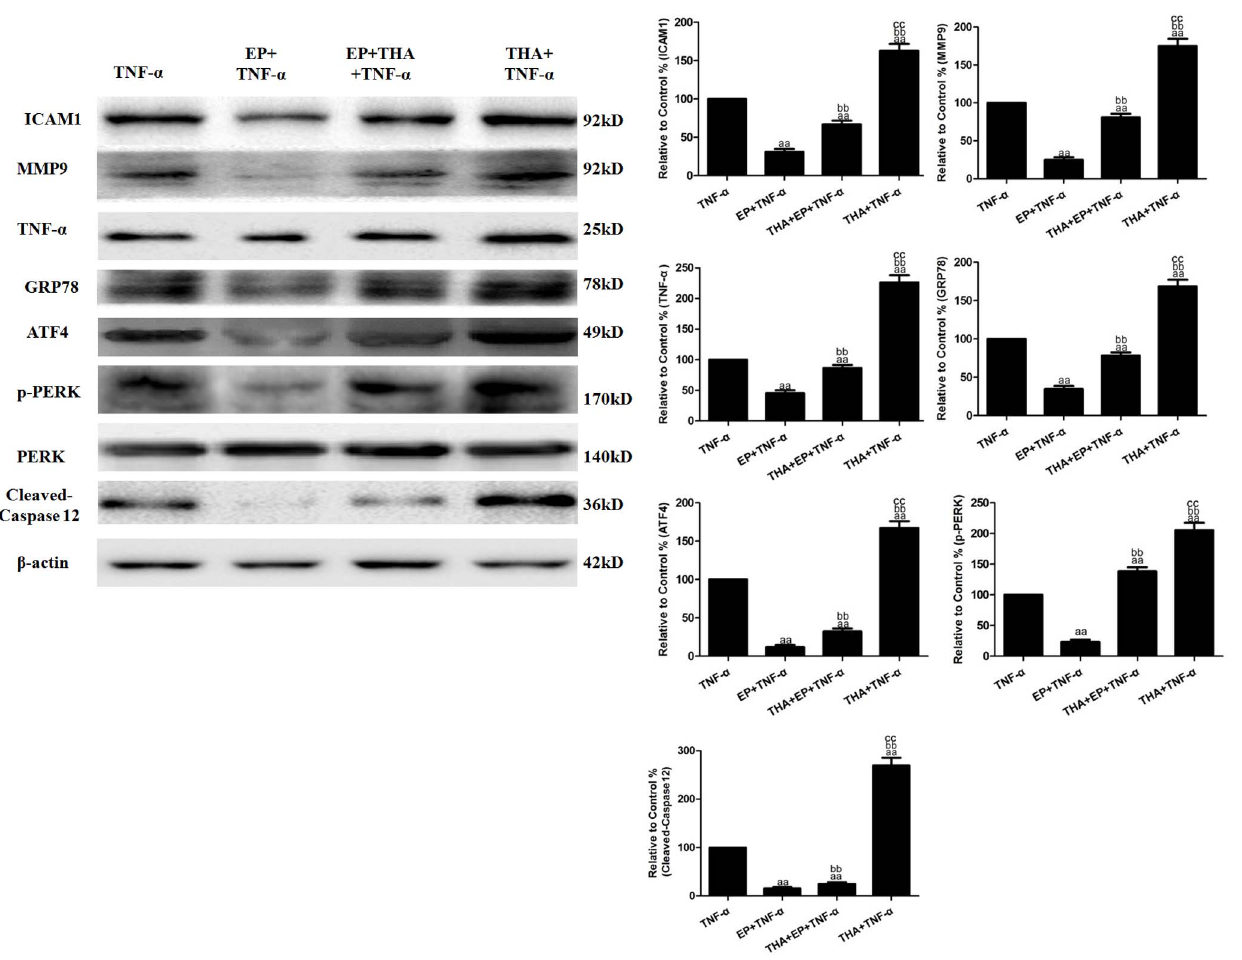
Figure 5. Effects of EP and THA co-treatment on the TNF- a -induced inflammatory protein and ERS-related molecules in HUVECs. Representative Western blot results showing ICAM1, MMP9, TNF- a , GRP78, ATF4, cleaved-caspase12, p-PERK and PERK protein expression. The results are expressed as the means ¡ SD, n 5 6. aa P , 0.01; compared with the TNF- a group, bb P , 0.01; compared with the EP + TNF- a group; cc P , 0.01, compared with the EP + THA + TNF- a group. EP, ethyl pyruvate; THA,